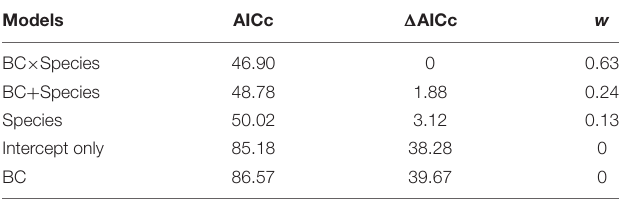
TABLE 5 | Values of the Akaike information criterion adjusted for small sample sizes (AICc), differences in AICc with respect to the best-fitting model ( (cid:49) AICc), and Akaike weights ( w ) for competing models that examined variation in the MI ind female.